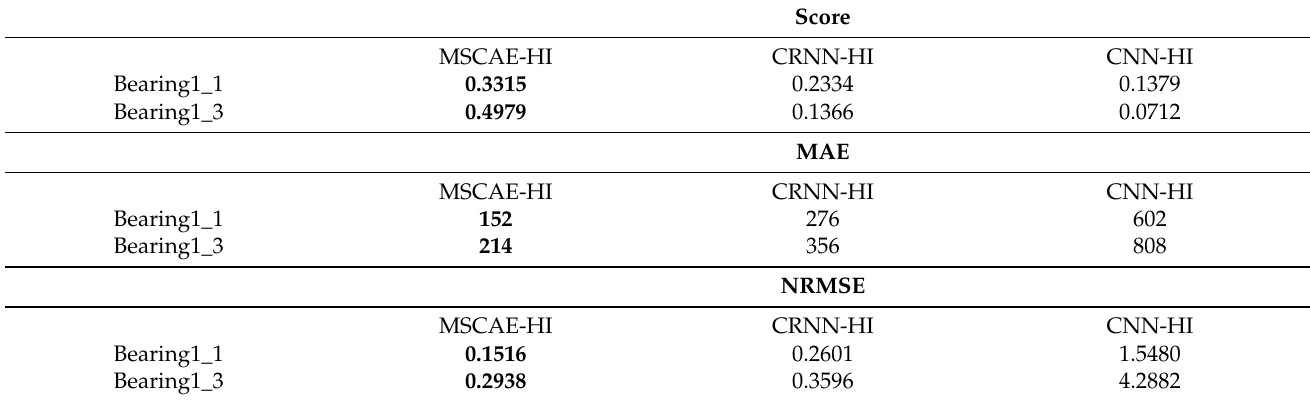
Table 4. Results of RUL prediction evaluation for 3